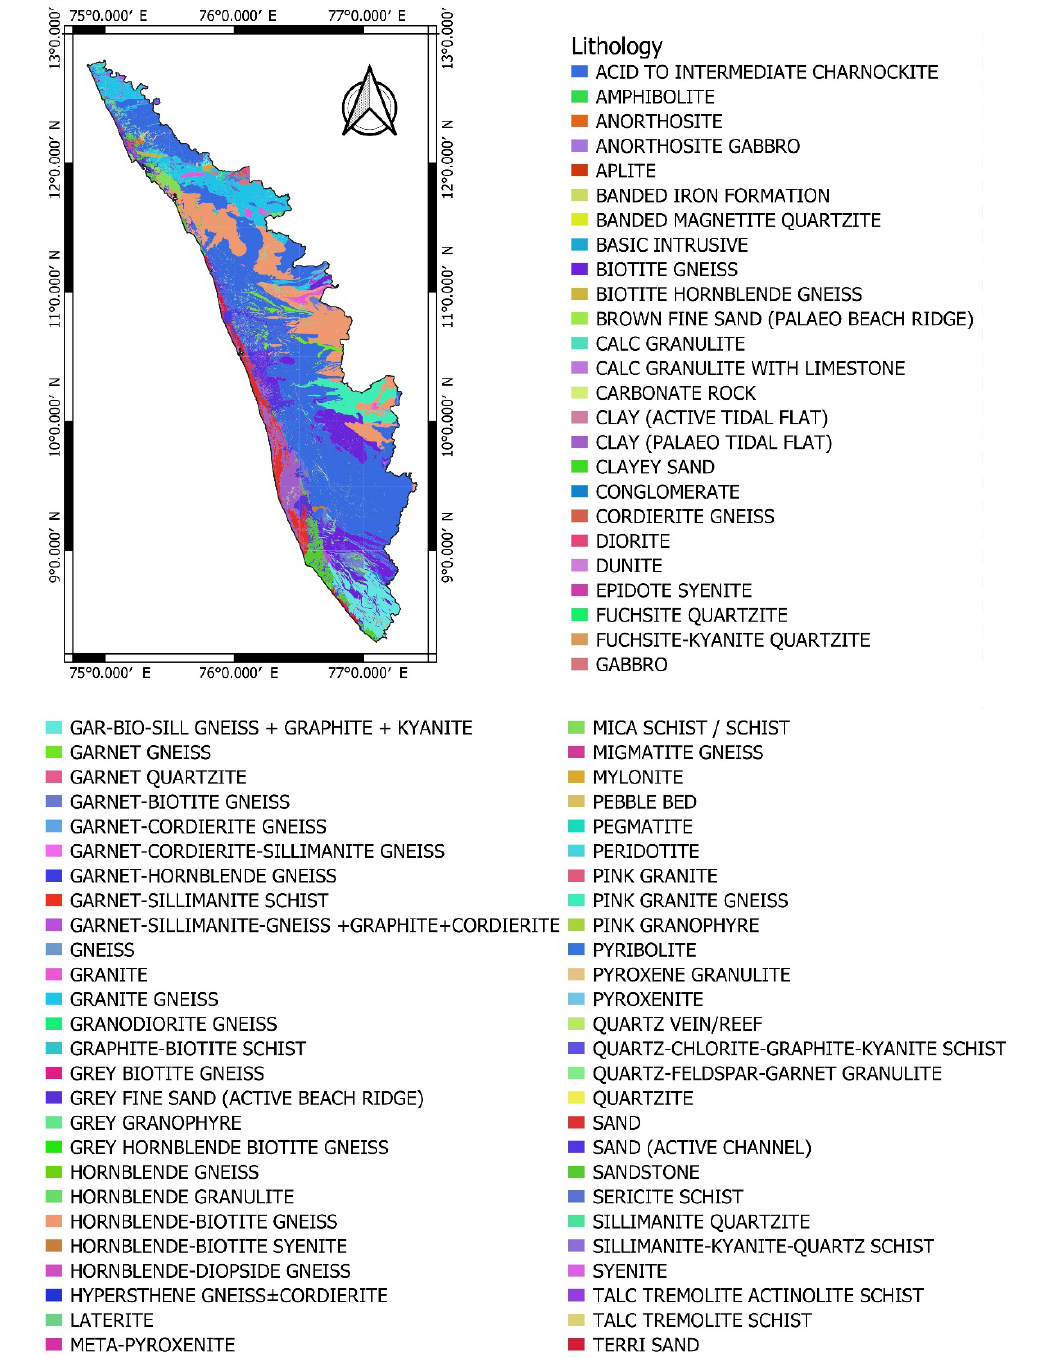
Figure 4. Kerala lithology map with legend subdivisions. In the month of January, 19 locations resulted in comparatively positive or negative slope probability percentage areas. The locations are Poonkulam, Pambadi, Minangadi,